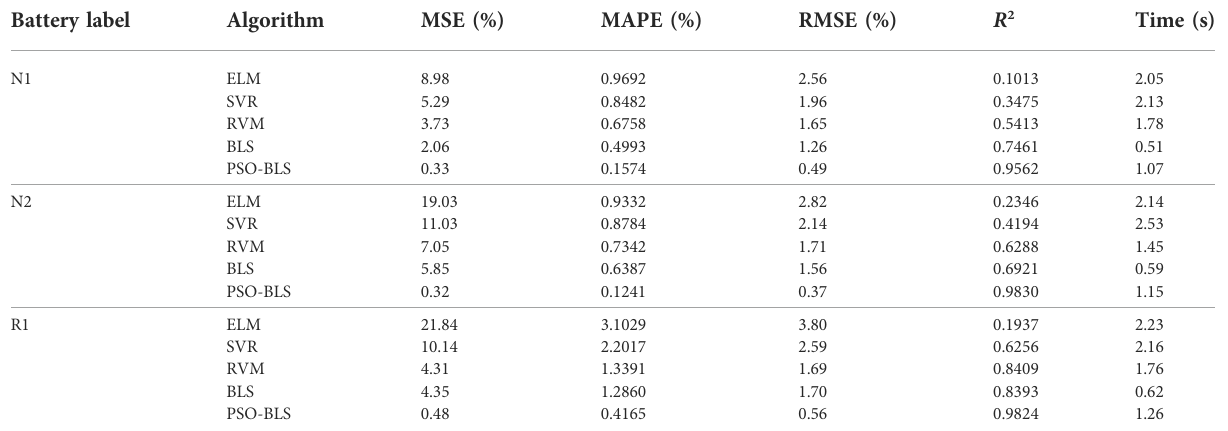
TABLE 5 The statistical errors of the compared experiment. Battery label